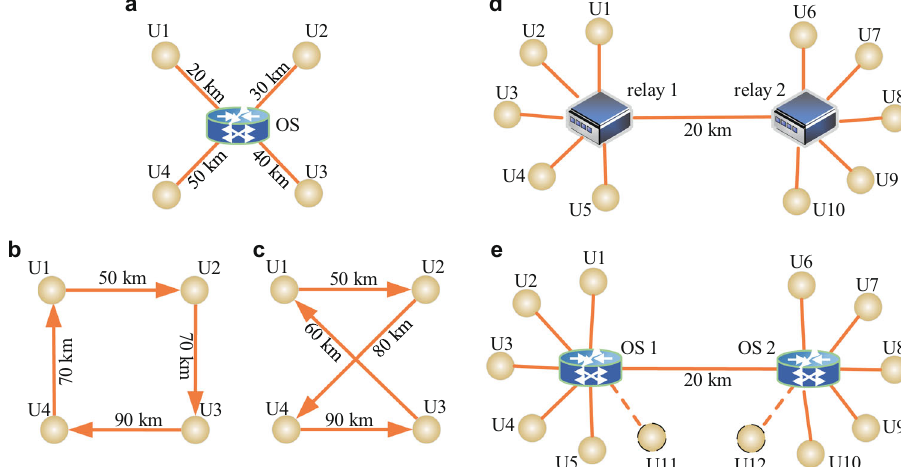
Fig. 3 PQC authentication in QKD networks. a All-pass QKD network. Four users are connected to each other through an optical switch. b Ring network. c Cross network. The actual distance between any two users is the sum of their respective distances from the optical switch. d A 10-node QKD metropolitan area network composed of two relay networks. e Trusted relays are replaced with optical switches to form an all-pass network. U11 and U12 are new users. See the text for the distance from each user to the trusted relay (optical